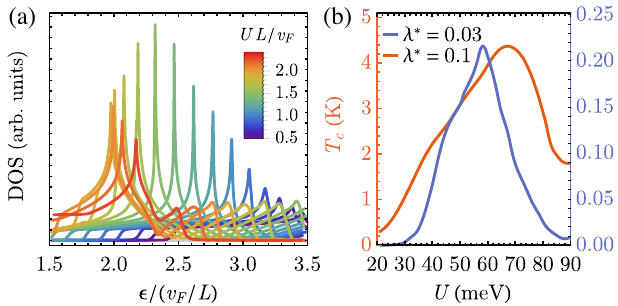
FIG. 5. (a) DOS of moir´e surface states under the C 6 potential in Eq. (4) with various U , which has a sharp high-order VHS-like peak in a wide range of U . Only DOS close to the peak is plotted for presentation. (b) Transition temperature T at different U (the c 80 K chemical potential is held exactly at the VHS) with ϵ D ¼ =L ¼ 435 K. The red axis on the left and the blue axis on and v F the right correspond to the red and blue curve, respectively, both of which are T in kelvin. T shows a wide peak around the c c potential that corresponds to high-order